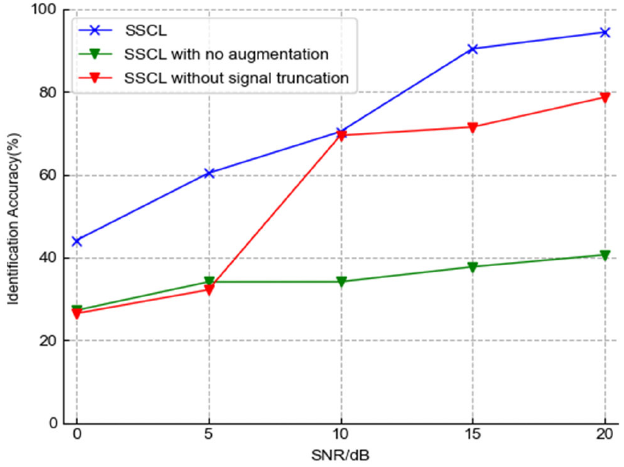
Figure 8. Identification accuracy with different data augmentation operations.